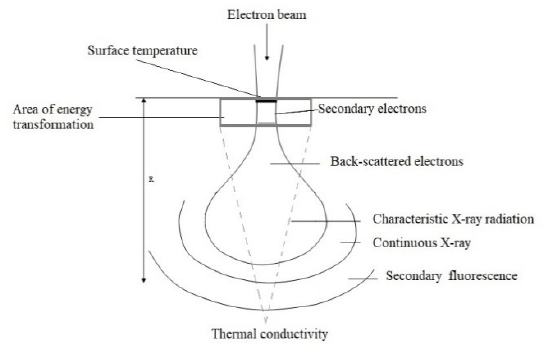
Figure 4. Scheme of electron-beam interaction with materials.